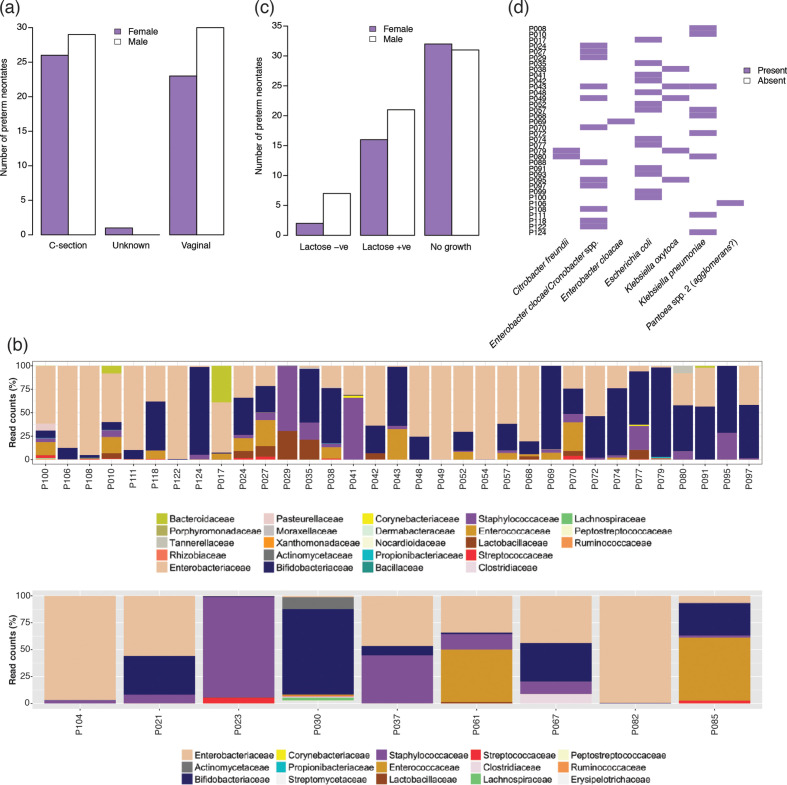
Summary information for UK cohort included in this study. (a) Breakdown of birth mode and sex of preterm neonates. (b) 16S rRNA gene sequence results for
Enterobacteriaceae
-positive samples: upper panel, samples from which lactose-positive isolates were recovered; lower panel, samples from which lactose-negative isolates were recovered. (c) Representation of lactose-negative and lactose-positive
Enterobacteriaceae
 isolated from faecal samples. (d) Tentative identities of lactose-positive
Enterobacteriaceae
 as determined by using API 20E.